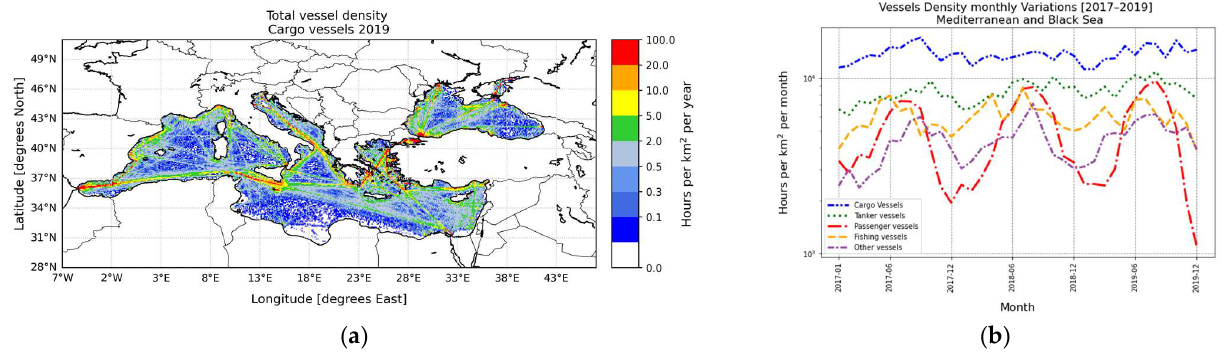
Figure 2. ( a ) Cargo vessel density for 2019 (in hours per km 2 per year) by EMODnet for the Mediterranean and Black Sea regions; ( b ) Monthly variation of the vessel density over the study regions in 2017–2019.